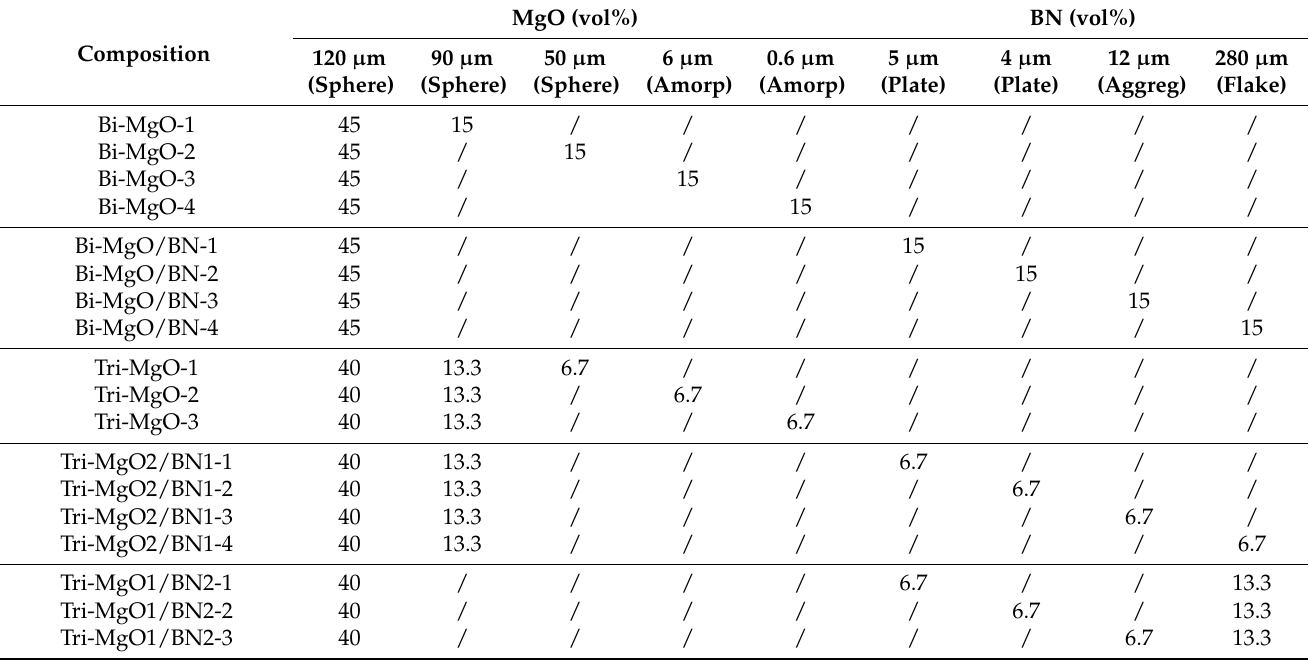
Table 2. Composition of bimodal and trimodal adhesives containing MgO and BN with various sizes and